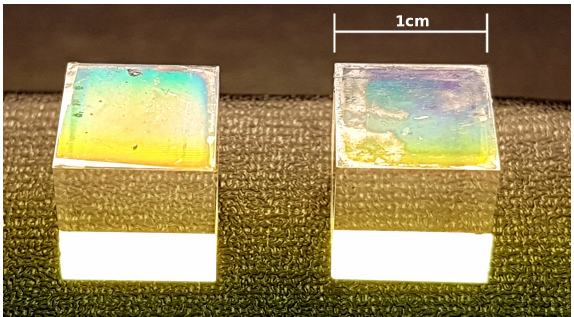
Figure 24. LYSO sample patterned with the pyramidal structure show in Figure 23. The left and right samples are NI1 and NI2, respectively. Up to 90% of the readout area is covered. The different colors observed around the surface are caused by the diffraction generated by the pattern: different angle of observation has different permitted wavelength